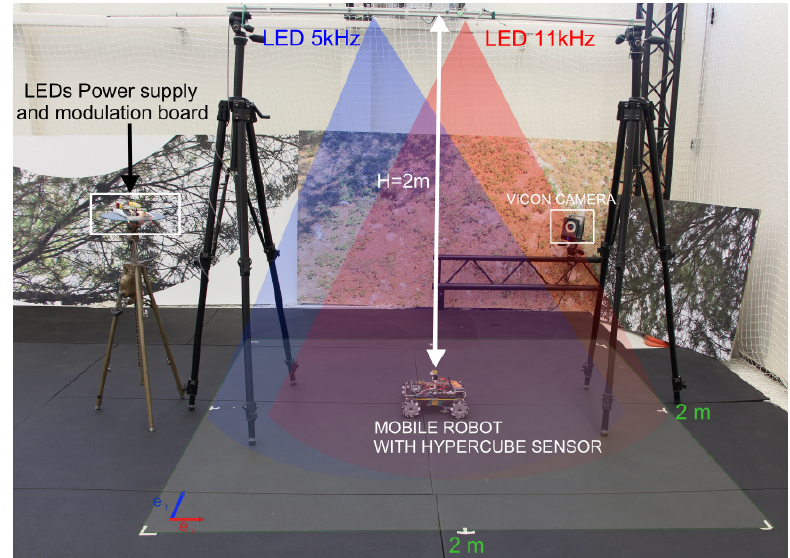
Figure 7. Picture of the experimental setup inside the motion capture system. The aim is to localize in 2D the mobile robot using HyperCube. The ground thruth is given by the Vicon cameras. The mecanum wheeled omni-directional robot is equipped with HyperCube, the localization coverage area is 2 m × 2 m. Two IR LEDs flickering at 5 kHz and 11 kHz were fixed on a horizontal bar placed above the robot at a height of 2